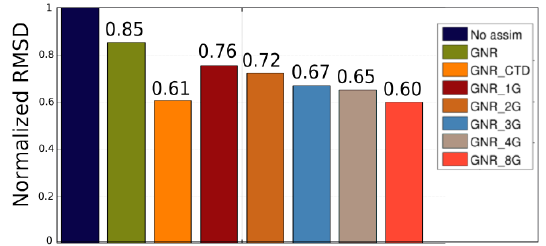
Figure 13. Average normalized RMSD against independent obser- vations in the REP14-MED areas on 22 June for the seven numerical